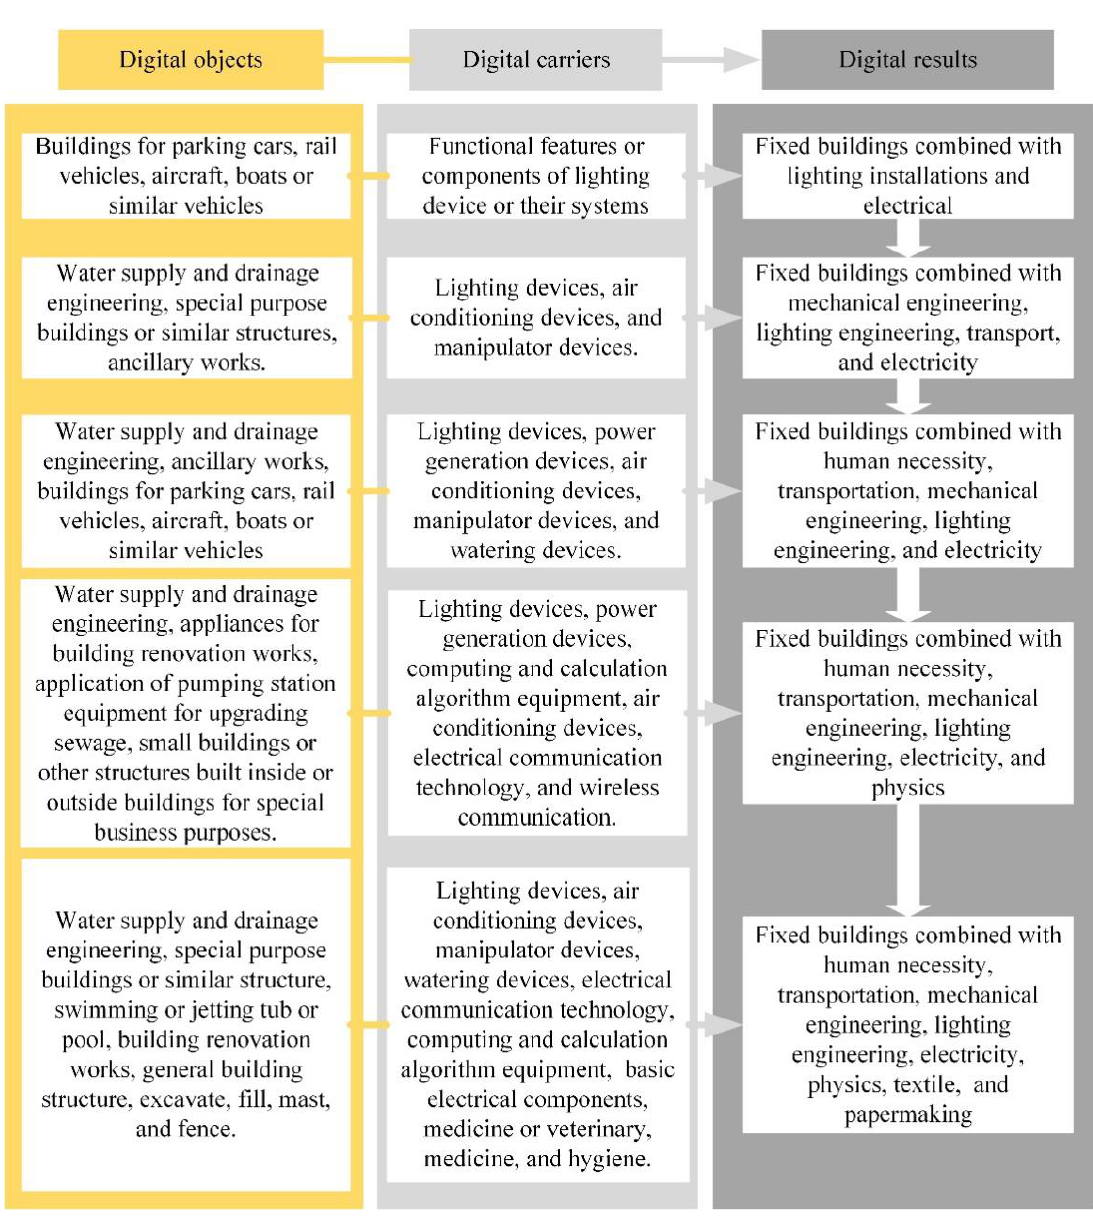
Figure 11. Evolution of innovation themes in the digital construction industry.